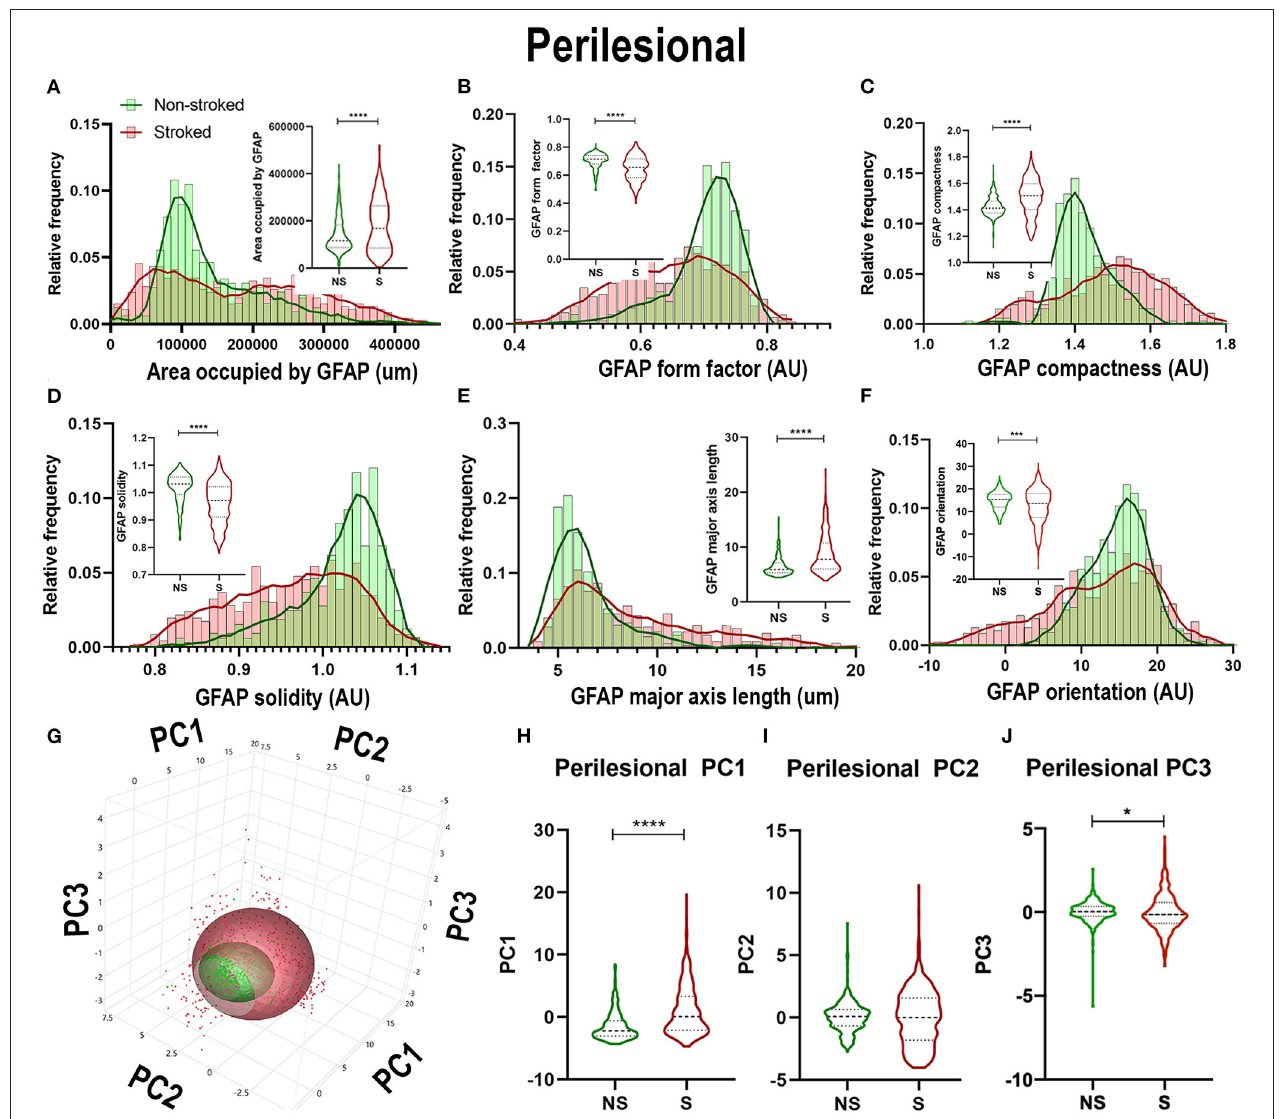
FIGURE 5 | Stroke resulted in larger A1-like morphological changes of GFAP + areas in perilesional tissue. Significant ( p < 0.0001) increases in GFAP + area occupied (A) , compactness (C) , and major axis length (E) were observed in ROIs of S ( n = 461 ROIs) animals compared NS ( n = 324 ROIs) animals. There was a significant decrease in form factor ( B ; p < 0.0001), solidity ( D ; p < 0.0001) and orientation ( F ; p = 0.0002) of IBA1 + ROIs in the perilesional region of S animals compared to NS animals. Upon PCA (G) analysis, a significant increase was observed in PC1 ( H ; p < 0.0001) and PC3 ( J ; p = 0.0162), but no significant difference was observed